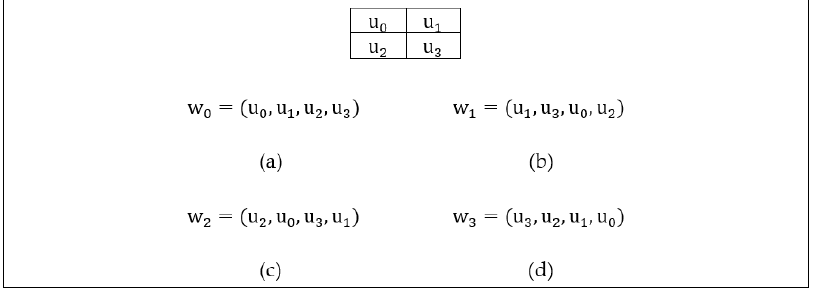
Figure 1. Production of vectors for four layers [3]: ( a ) Layer-1; ( b ) Layer-2; ( c ) Layer-3; ( d ) Layer-4.